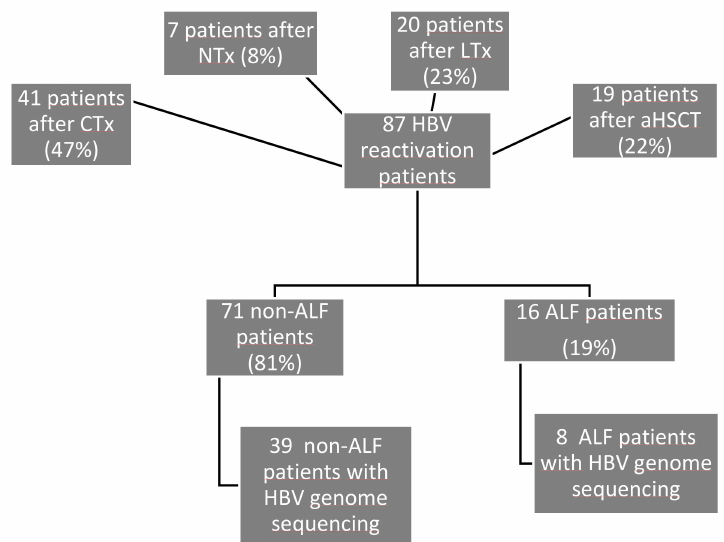
Figure 1. Flowchart of the patients analyzed in this study. ALF: acute liver failure, CTx: group of patients with hematological or oncological diseases after chemotherapy, aHSCT: group of patients after allogeneic hematopoietic stem cell transplantation, NTx: group of patients after kidney transplantation, LTx: group of patients after liver